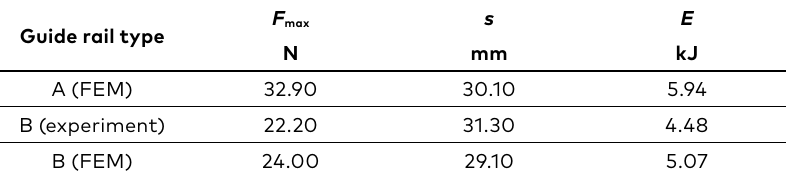
Table 3. Characteristic values in three-point bend test of A and B guide rail